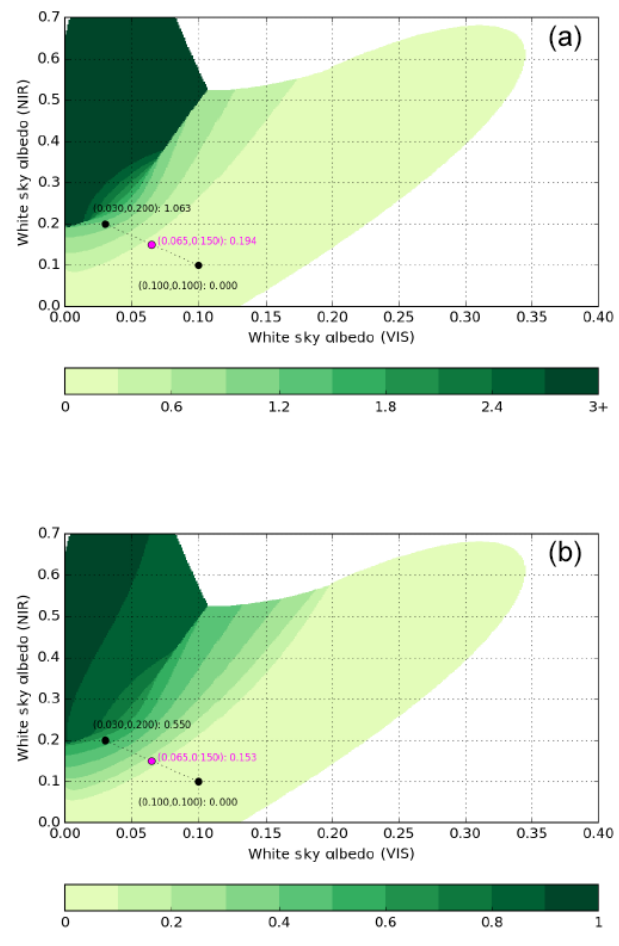
Figure 6. Effective LAI (a) and FAPAR (b) over albedo spectral plane retrieved using no-snow prior parameters (Table 1) and for albedo uncertainty of 5% in both wavebands. Retrievals yielding a misfit function value J above 3 have been masked